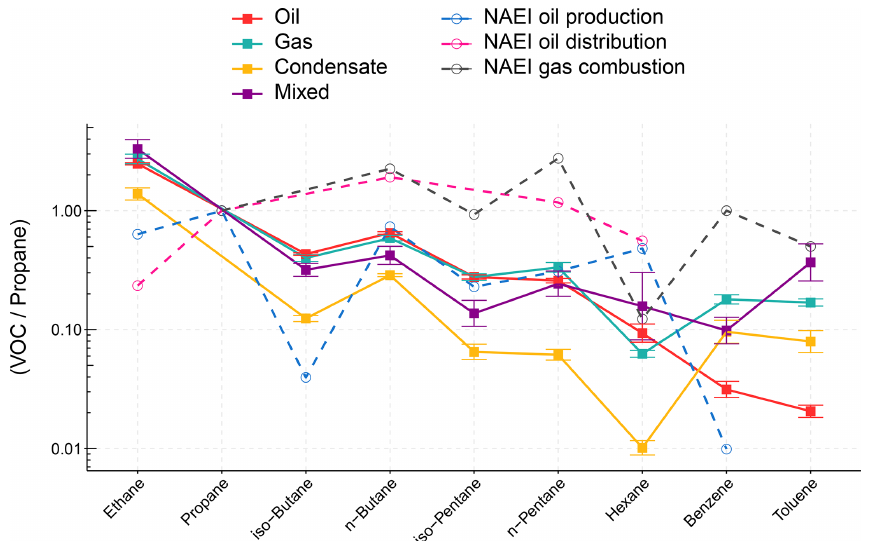
Figure 8. Emission ratios of VOC with propane calculated by reduced major-axis regression for each offshore field type (note the log scale). Error bars represent the 95% confidence intervals. The dashed lines show the ratio obtained from the NAEI speciation profiles in Passant (2002) for oil production, oil distribution and gas